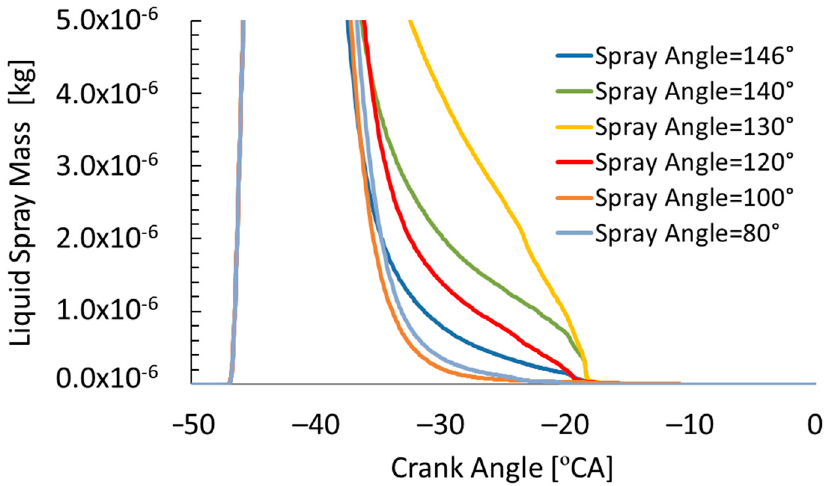
Figure 27. Effect of SIA on liquid spray mass history for an ESI with SOI of − 50 °CA ATDC.